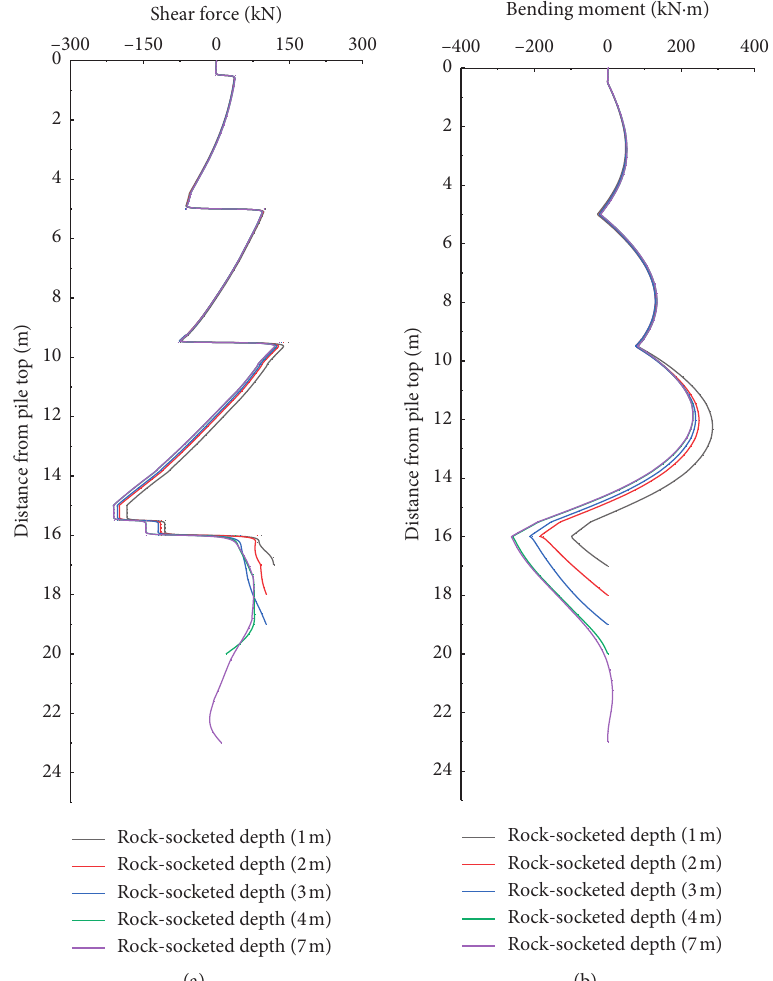
Figure 20: Pile internal force diagram. (a) Shear diagram. (b) Bending moment